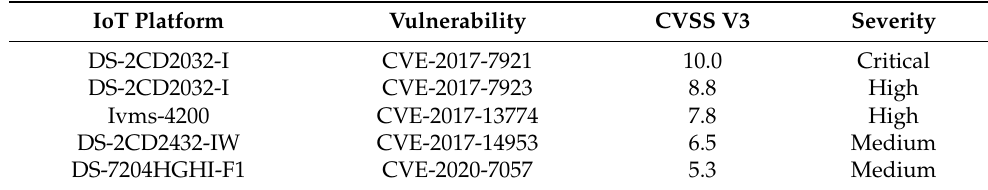
Table 2. Vulnerability, CVSS score and severity.